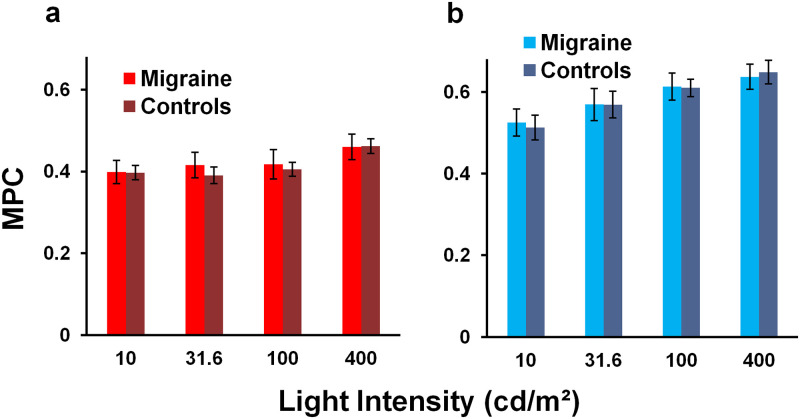
Mean MPC responses of the left eye.MPC was measured in response to four light intensity steps, each of 400 ms in duration, using (a) red and (b) blue light stimulation. Error bars represent 95% confidence intervals. There were no statistically significant differences between the migraine and control groups at each stimulus intensity following red or blue light stimulation.